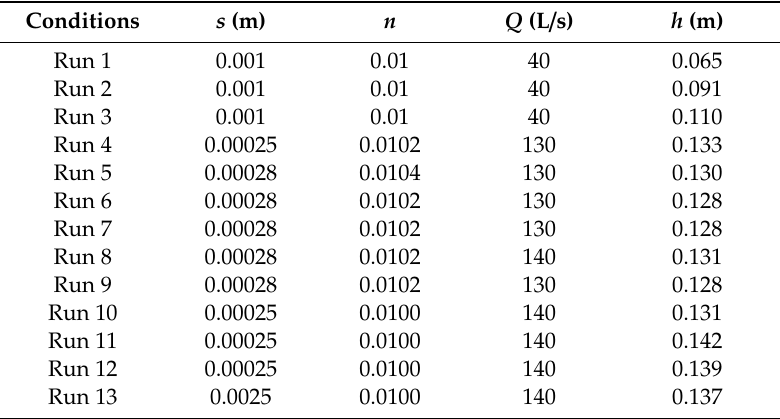
Table 1. Summary of all the experimental conditions.